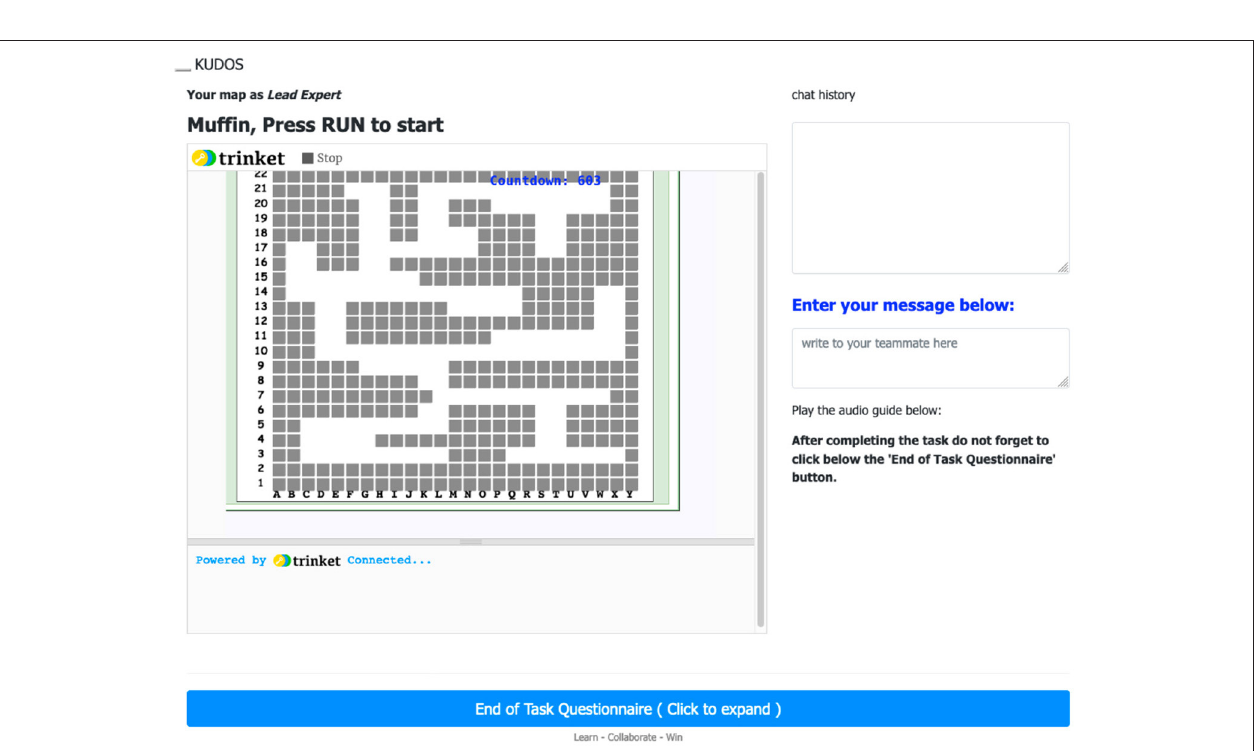
FIGURE 3 | Lead Expert’s view of the maze. The participant could see the map, but did not know where the bomb and the Defuser were placed in the map.